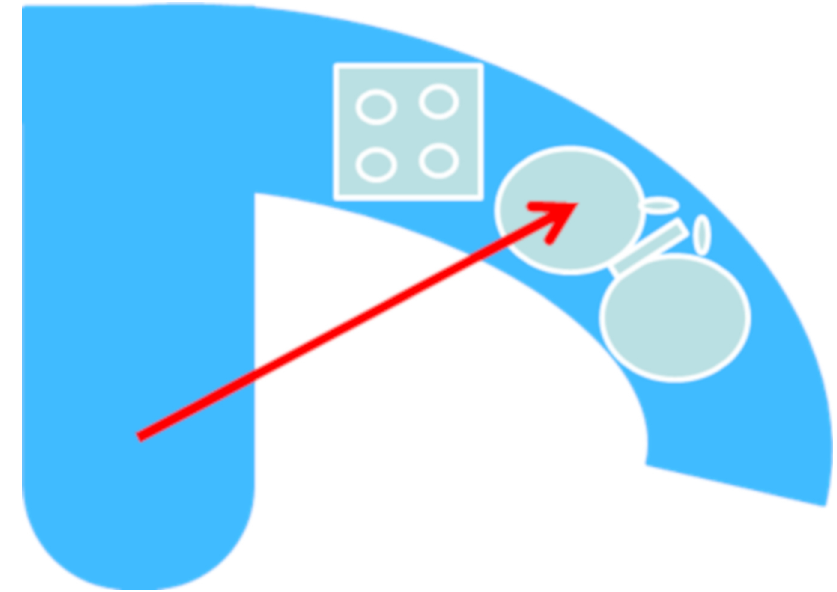
Fig. 3. Map of the kitchen and movement of JS